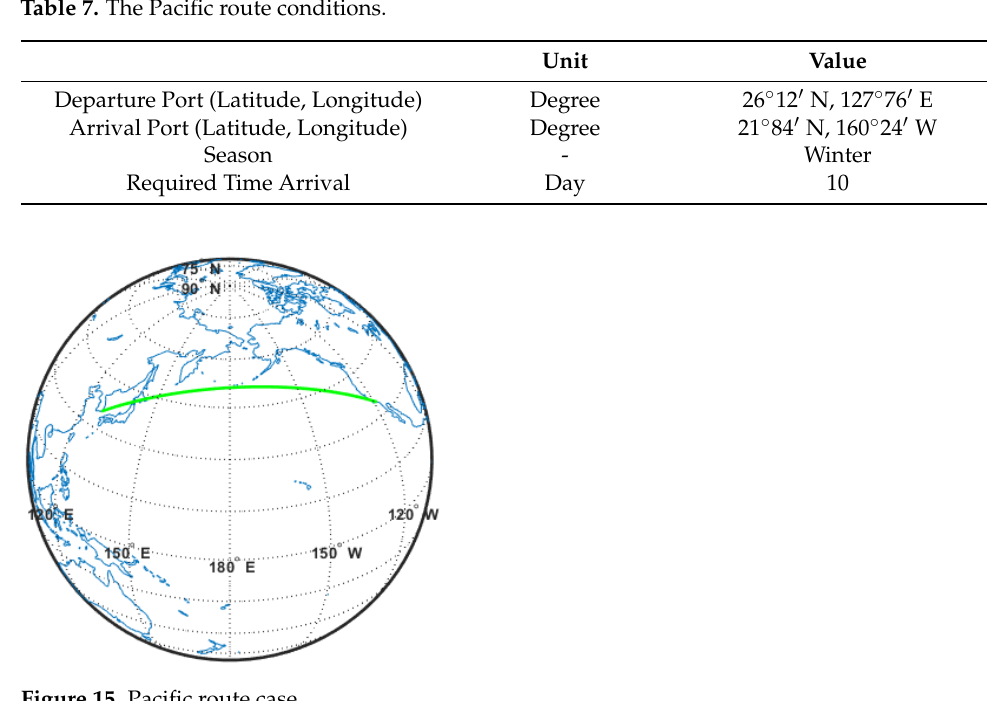
Table 7. The Pacific route conditions.